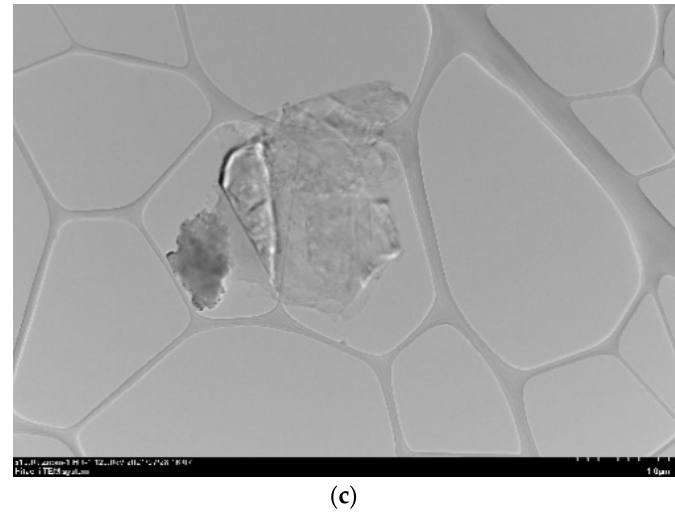
Figure 3. ( a ) FESEM for GnP; ( b ) XRD for GnP; ( c ) TEM for GnP.